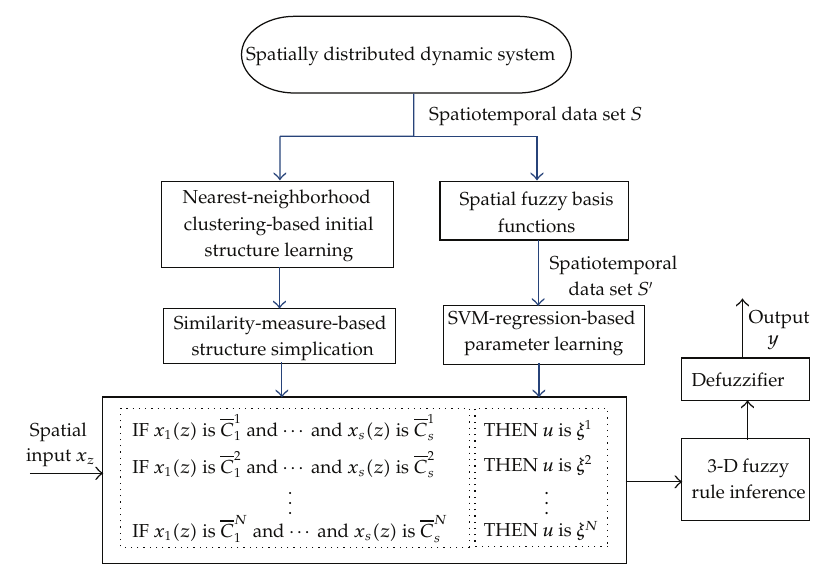
Figure 3: Conceptual configuration of a clustering and SVM-regression learning-based 3-D